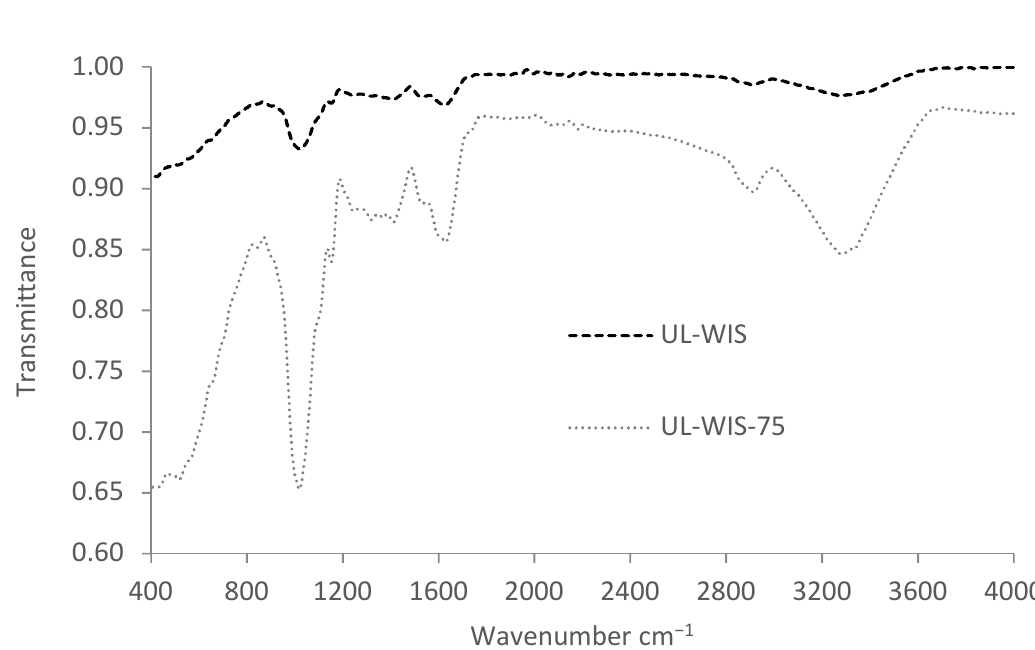
Figure 5. IR spectra of the water insoluble substance (UL-WIS) dry U. lactuca before and after 75 min of contact with MB. The infrared spectrum of nontreated dried algae (UL-NA: control) (Figure 2) gives the number of biosorption peaks of untreated UL-NA biomass, which shows its complex nature. Thus, the spectrum shows that several functional groups, such as –OH and –NH at 3307 cm − 1 , correspond to the alcohols, phenols, and carboxylic acids of cellulose and lignin, and to proteins, respectively [47]. Thus, biosorption of MB dye on algal biomass is attributed to the phenolic and acidic groups. In addition, two small peaks correspond to the aliphatic –CH in the methyl group of –CH 2 in lipids at 2958 cm − 1 and 2895 cm − 1 . Aromatic C=C and C=O at 1638 cm − 1 correspond to protein amide I; the secondary amine group at 1579 cm − 1 corresponds to protein amide II; N–H bending at 1430 cm − 1 , –CH 3 bending at 1369 cm − 1 , -SO 3 stretching/P=O at 1236 cm − 1 , C − O − C groups of polysaccharide at 1101 cm − 1 , and C − O − H groups of polysaccharide at 1048 cm − 1 and 1050 cm − 1 show